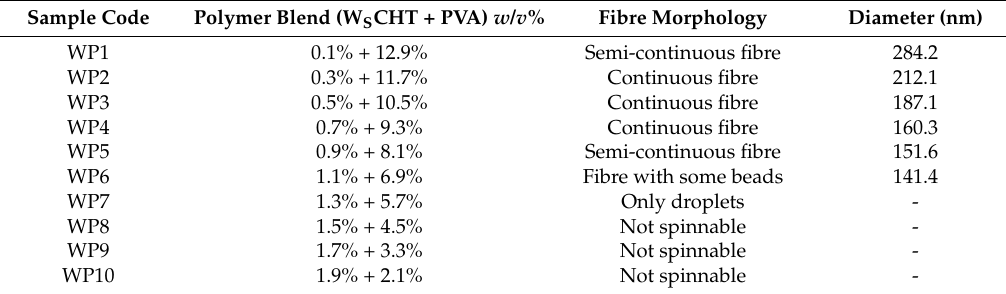
Table 2. Experimental condition in synthesis of